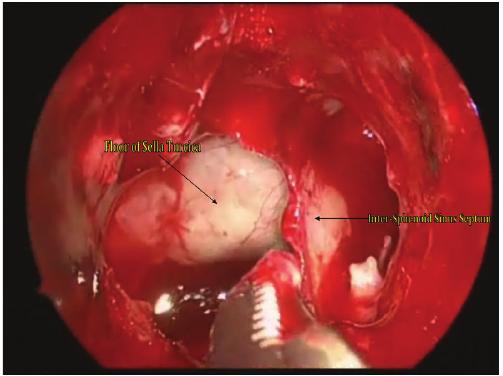
Figure 2: Intraoperative view through the operative endoscope revealing the intersinus septum within the sphenoid sinus and the floor of the sella turcica.